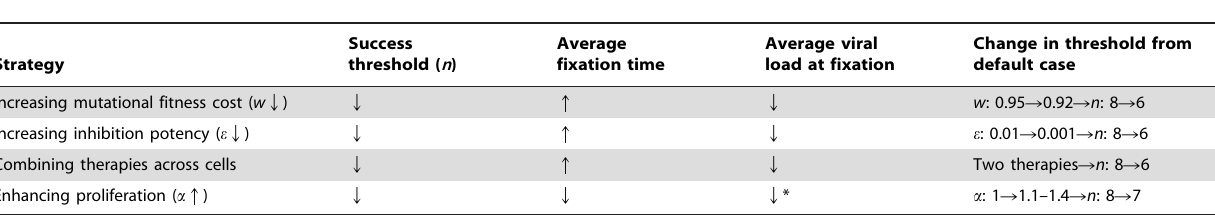
Table 1. Influence of strategies for delaying escape on the average treatment